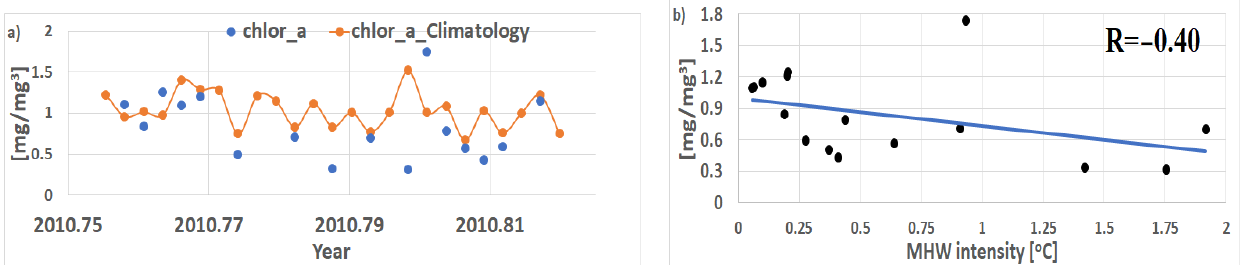
Figure 13. Scatter plots of marine heat wave intensity during the study case 2 (29 September 2010 to 23 October 2010) and surface latent heat flux ( a ), surface sensible heat flux ( b ), surface net thermal radiation ( c ), surface net solar radiation ( d ), and total heat loss to the atmosphere ( e ).